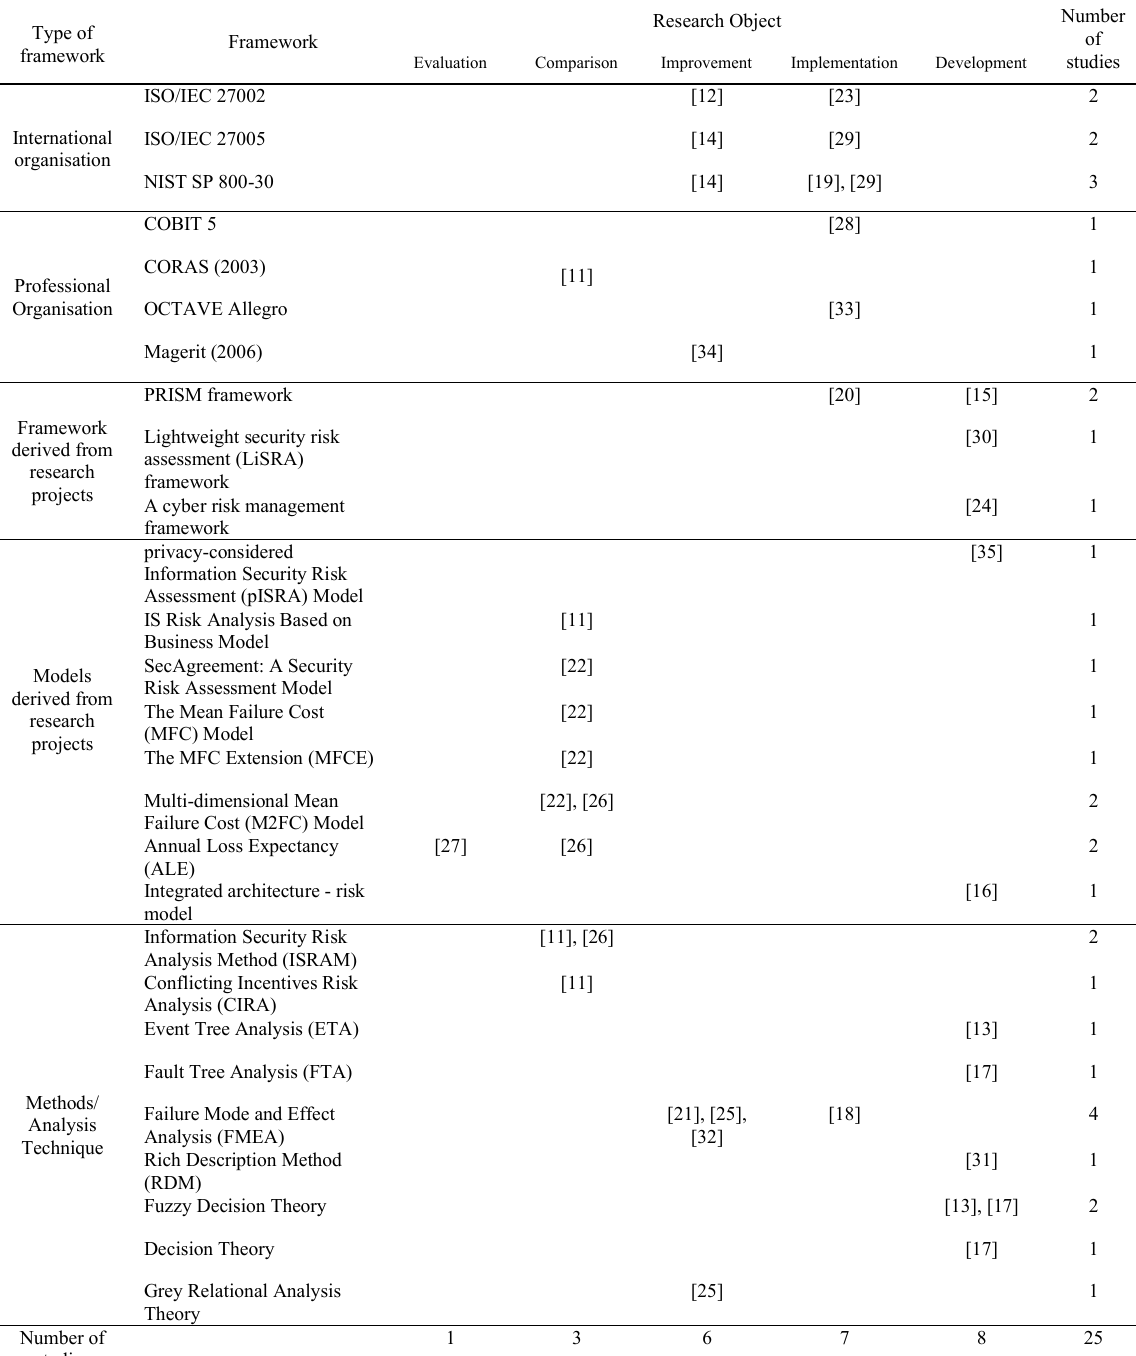
TABLE 2 R ESEARCH O